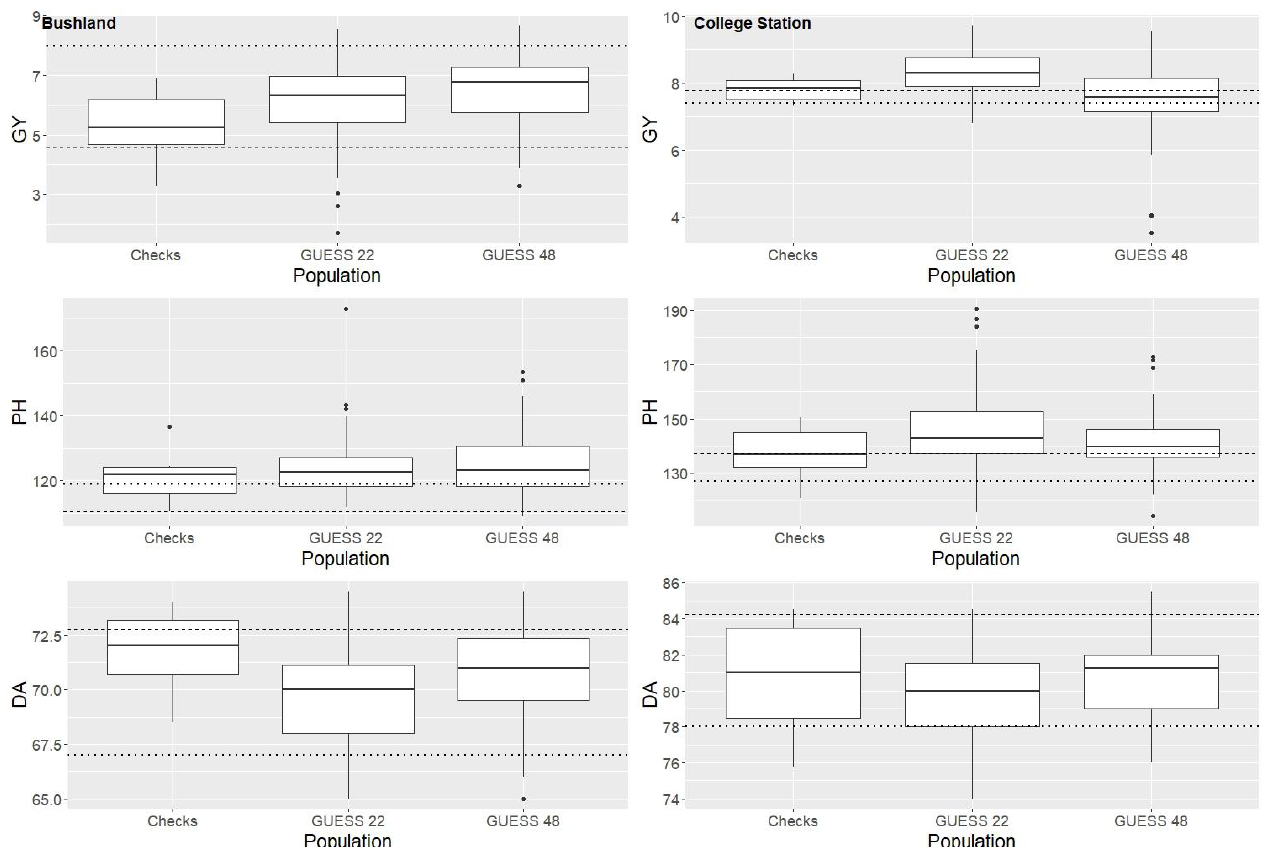
Figure 1. Boxplots of BLUEs for grain yield in tons/ha (GY), plant height in cm (PH), and days to anthesis (DA) in College Station and Bushland, TX. Each plot contains the distribution of BLUEs for introgression populations GUESS 22 and GUESS 48 in hybrid combination, as well as elite check hybrids from the Texas A&M AgriLife sorghum breeding program. The dashed line represents the trait mean of the recurrent parent for the introgression populations in hybrid combination, and the dotted line represents the commercial check hybrid DK37-07.